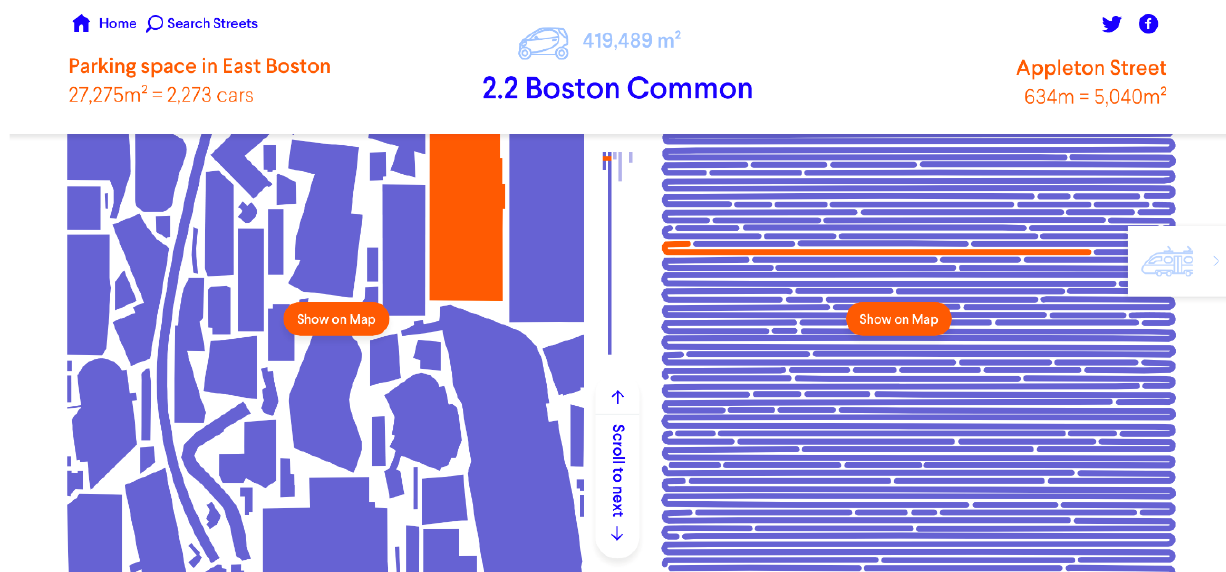
Figure 3. The main interface allows scrolling through all mobility spaces, here shown for cars in the city of Boston: on the left a segment of the bar of packed parking spaces, on the right the coiled streets with all individual elements explorable in detail (one on each side highlighted in